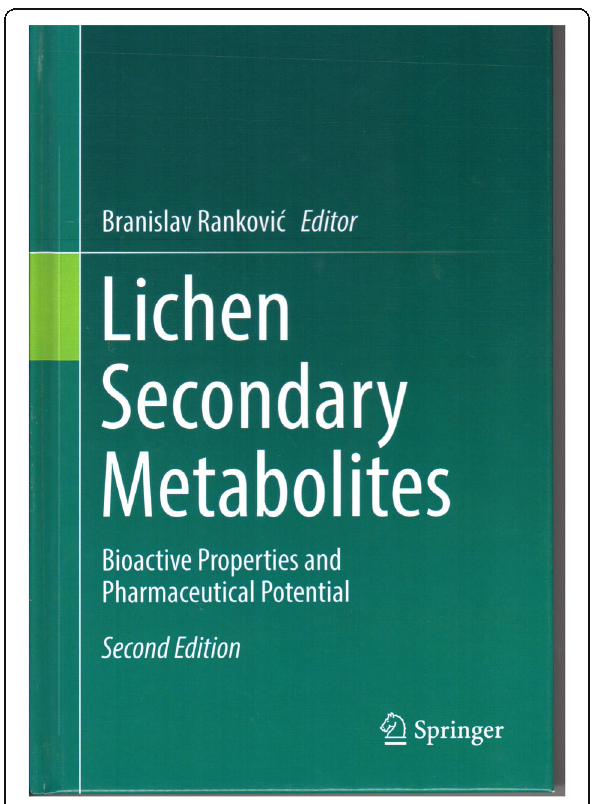
Fig. 34 Lichen Secondary Metabolites (2nd edn,